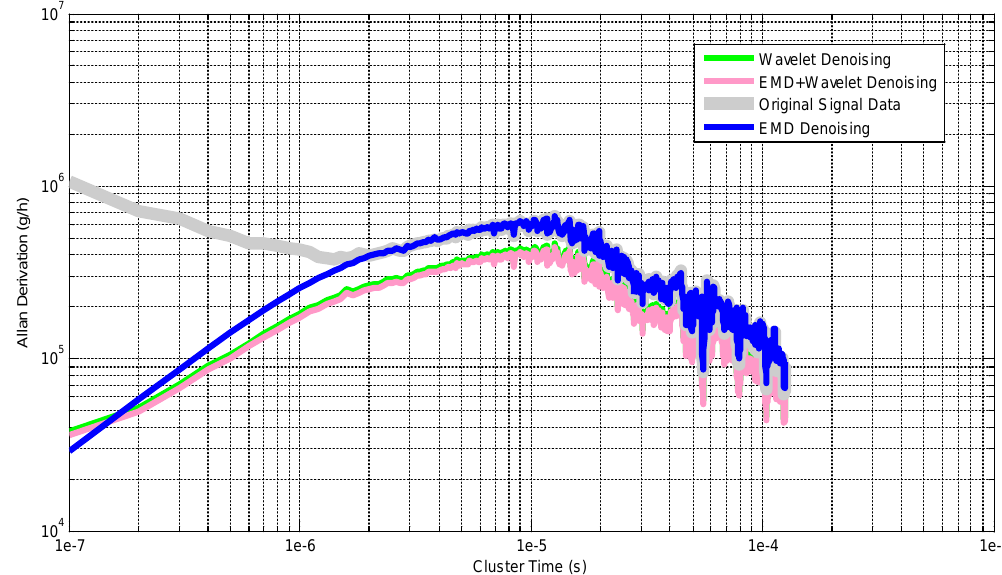
Figure 9. Allan derivation results of the denoising method during “Preparation Stage”.